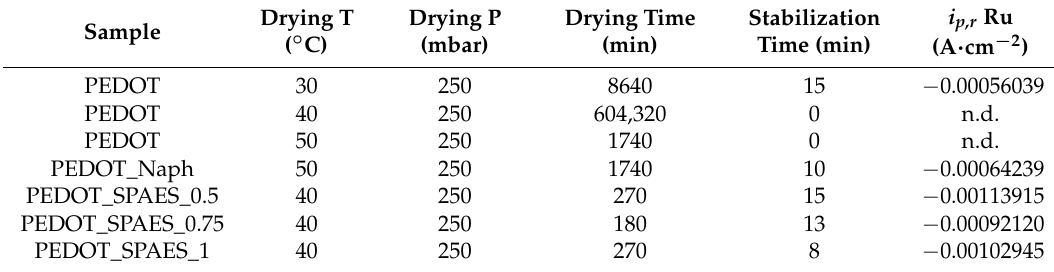
Table A4. Drying temperature, pressure, and time of PEDOTs’, PEDOT_Naphs’, and PEDOT_SPAESs’ polymeric solutions in NMP, and the stabilization time and current of the corresponding modified